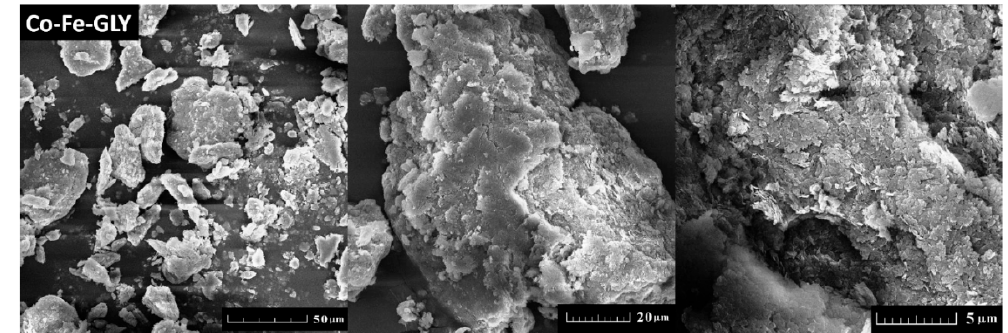
Figure 2. SEM micrographs of Co-Fe-GLY obtained at various magnifications.